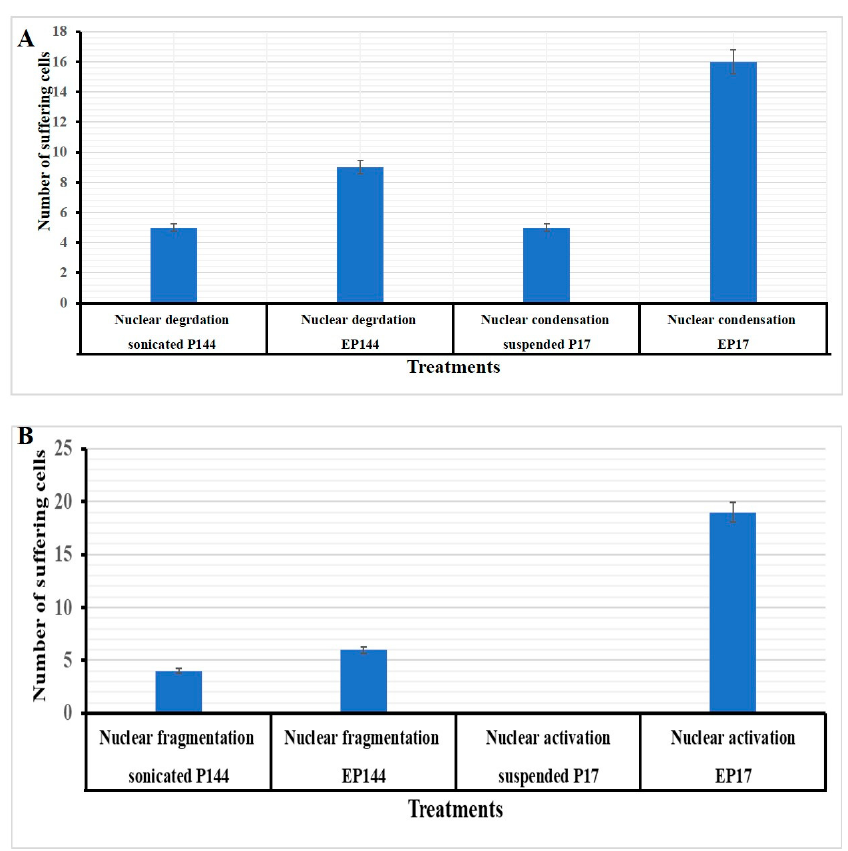
Figure 9. Quantification analysis of nuclear morphology after DAPI staining. ( A ) Hep3B cells exposed to encapsulated and non-encapsulated P17 and P144. ( B ) SNU449 cells exposed to encapsulated and non-encapsulated P17 and P144.